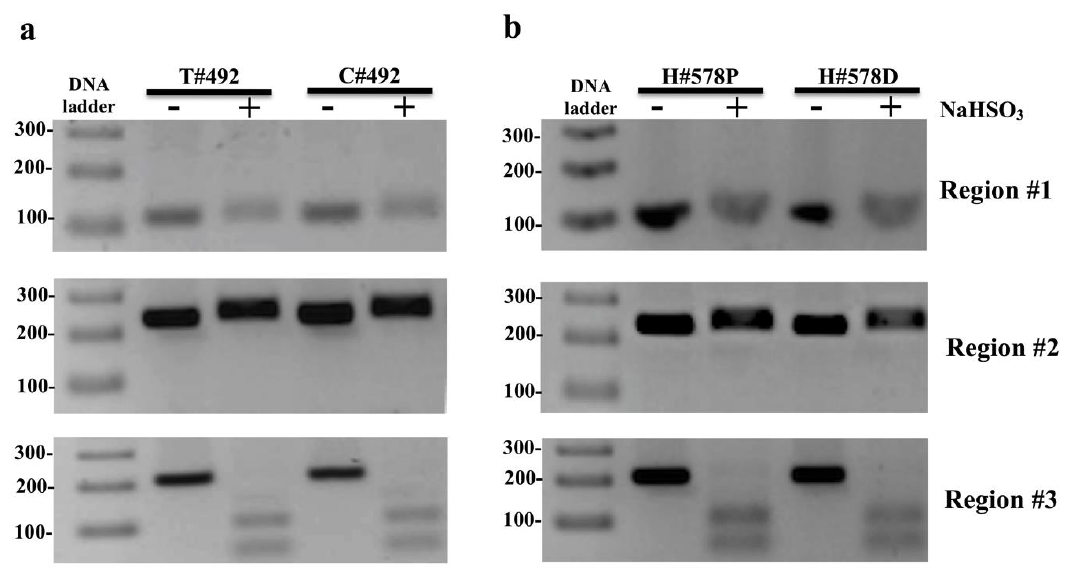
Figure 2. Representational combined bisulfite restriction analysis (COBRA) results of 3 regions